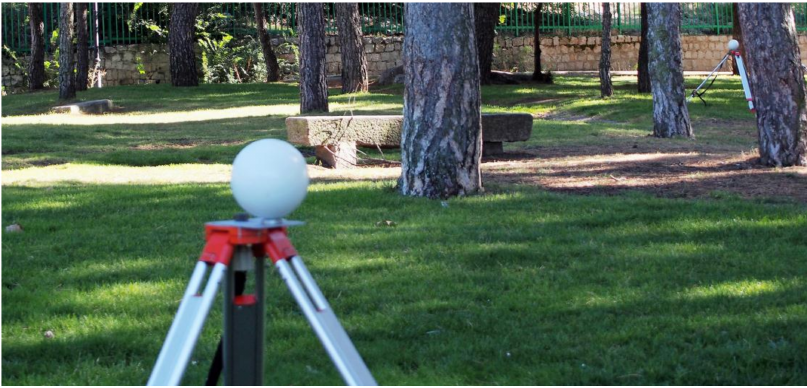
Figure 6. Reference network established for the study confirmed by spheres of 200 mm